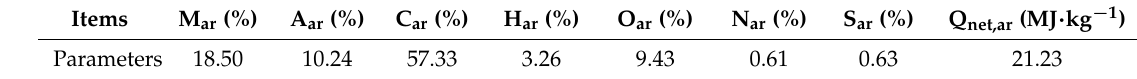
Table 1. Proximate analysis of the coal.